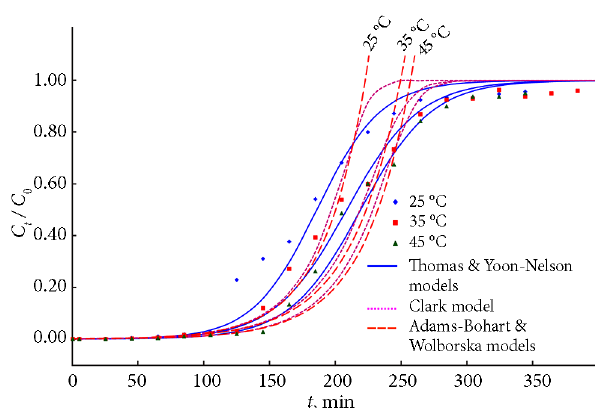
Figure 9. Effect of temperature on breakthrough curve for As(V) adsorption removal by the PC-Fe/C adsorbent prepared with eucalyptus wood template (influent As(V) concentration: 20 mg/L; flow rate: 5.136 mL/min; pH: 3; adsorbent mass: 2 g;